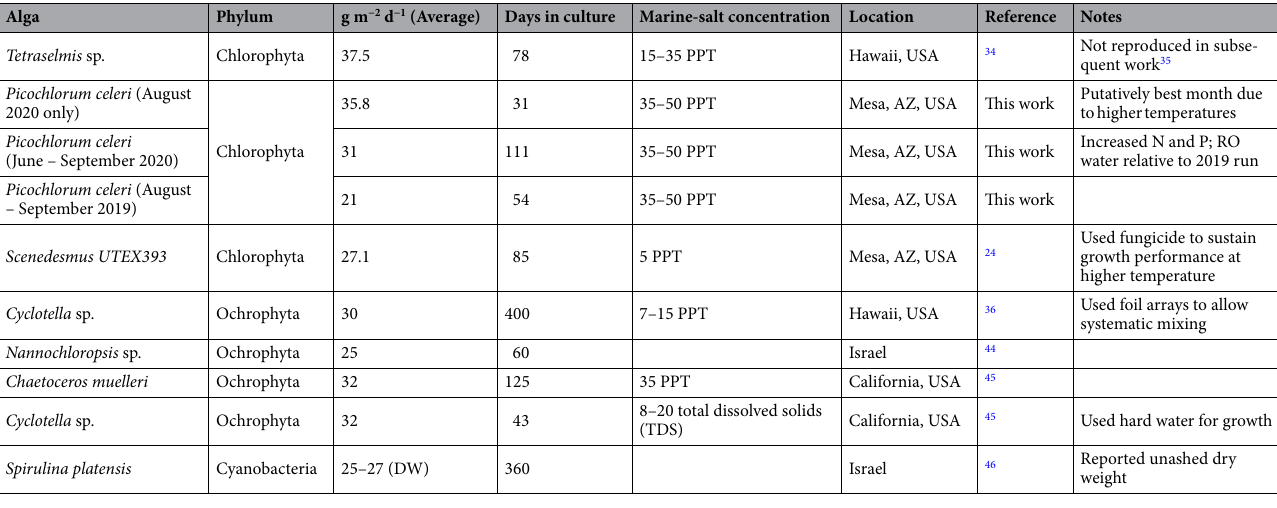
Table 6. Outdoor productivities of various high-performance algae for at least 30